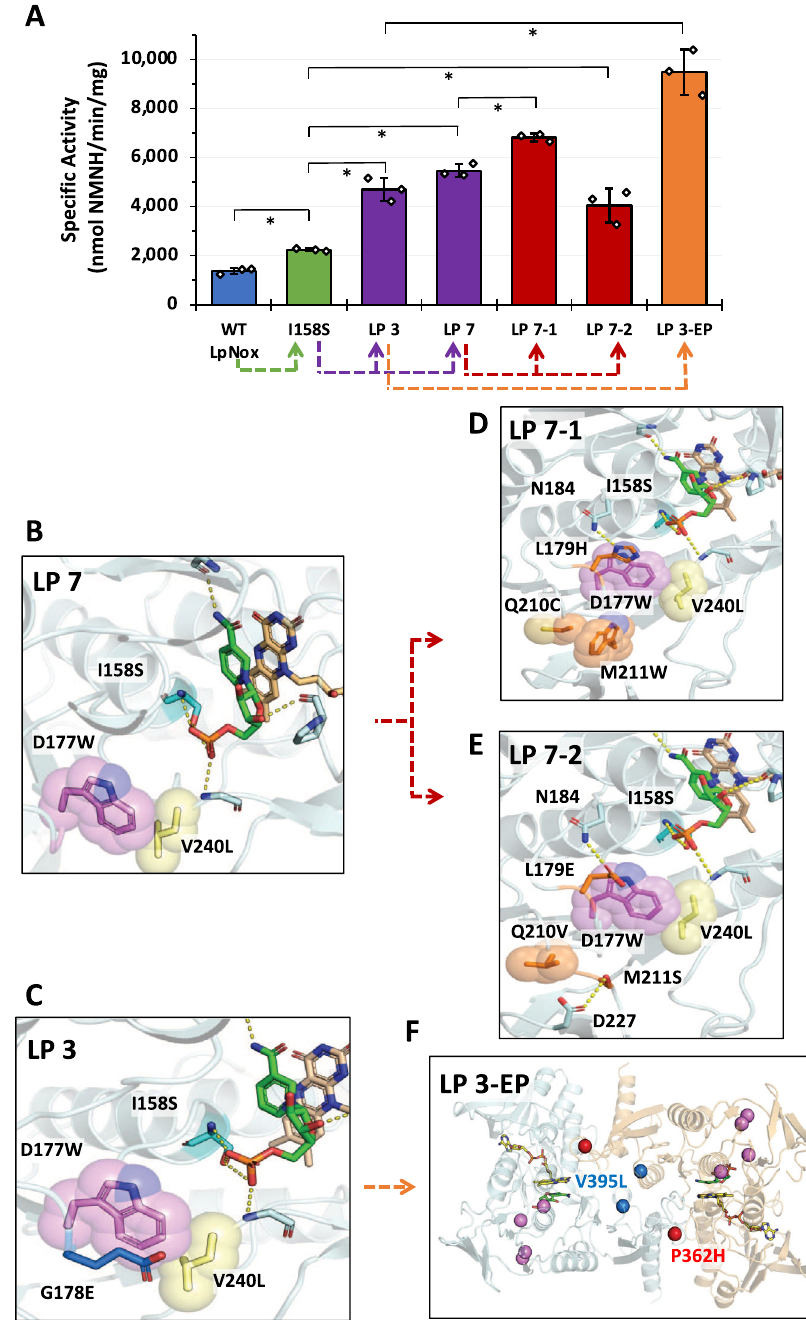
Fig.2| Lp Noxvariantsdiscoveredthroughgrowthselection.A Enzymespeci fi c activities with NMNH. Wild-type Lp Nox (blue) showed an initial level of activity thatwasincreased~2-foldwithrationaldesignofI158S(green).Growthselection ofcombinatorialmutantsgeneratedthroughthe fi rstround(purple)andsecond round (red) of site-saturation mutagenesis at the cofactor binding site and the second sphere, respectively, led to LP 3, LP 7, and LP 7-1, LP 7-2. A fi nal step of random mutagenesis with error-prone PCR led to LP 3-EP (orange) that displays ~10-fold increase in NMNH activity compared to the wild type. The dashed line underthex-axisindicatestheparentalvariantsanddifferentselectionstrategies. For all samples, n =3 biologically independent replicates. For statistics, WT to I158S, p =0.00038; I158S to LP 3, p =0.012; I158S to LP 7, p =0.0023; LP 7 to LP 7-1, p =0.0016; I158S to LP 7-2, p =0.045; LP 3 to LP 3-EP, p =0.0014. B Model of LP 7 binding pose with FAD (peach) and NMNH (green). I158S forms a polar contact with the NMNH phosphate, while D177W and V240L rigidly fi ll the